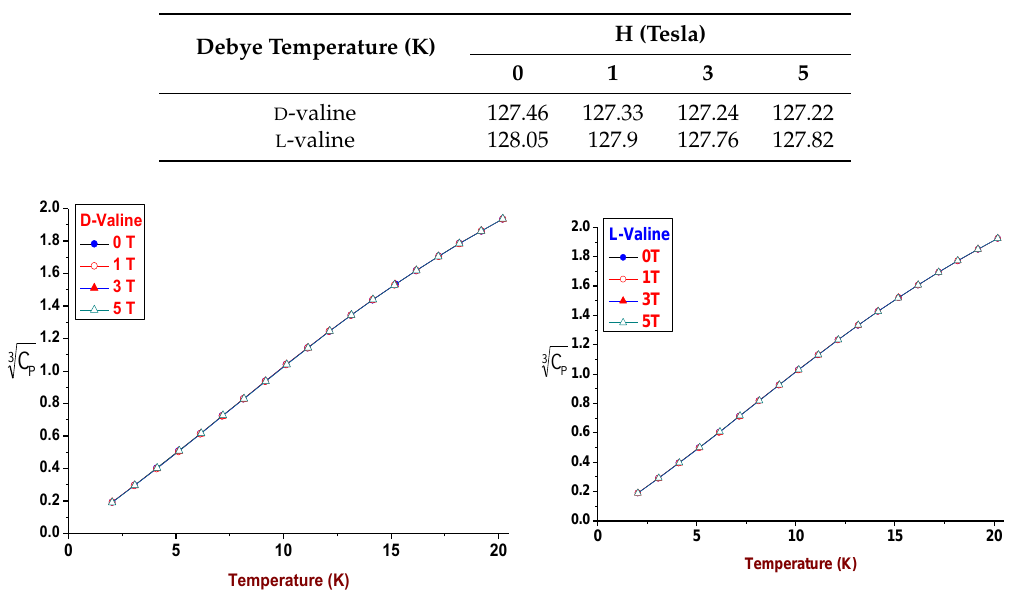
Table 4. Debye temperature of D - and L -valine.